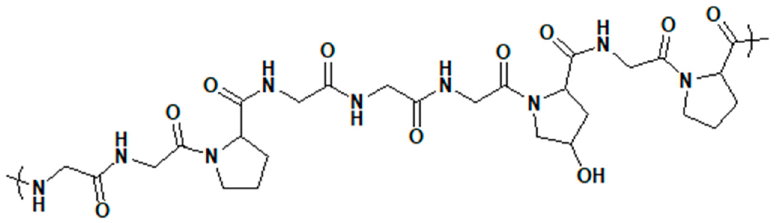
Figure 1. Chemical structure of Gelatin [14].